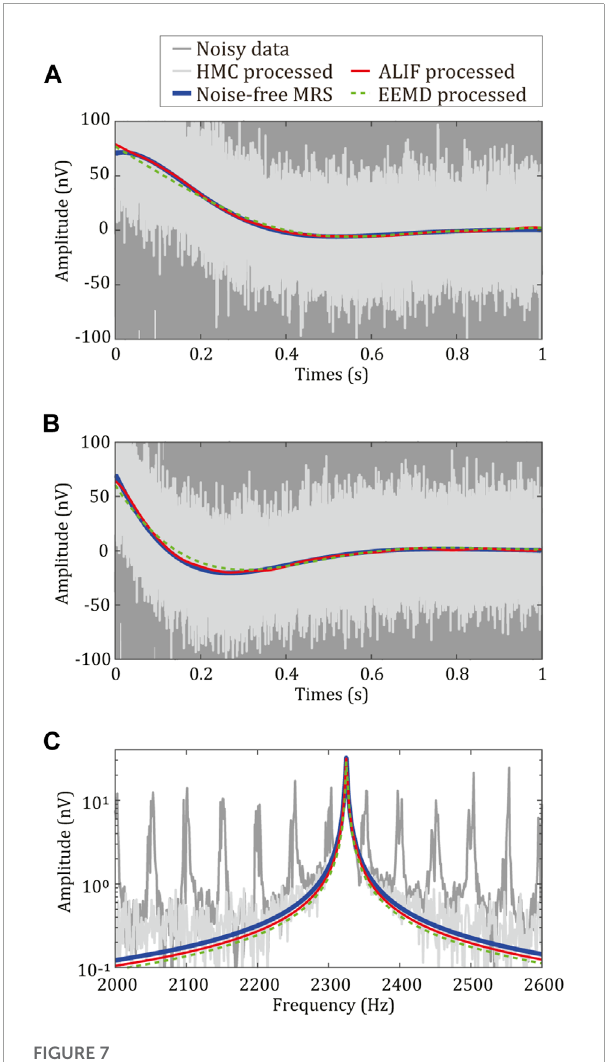
FIGURE 7 Comparison of signal extraction results by ALIF, HMC and EEMD algorithms. (A) ALIF, HMC and EEMD algorithms extract the time-domain image of the real part of the signal; (B) Time domain image extracted by ALIF, HMC and EEMD algorithms; (C) Frequency domain images extracted by ALIF, HMC and EEMD